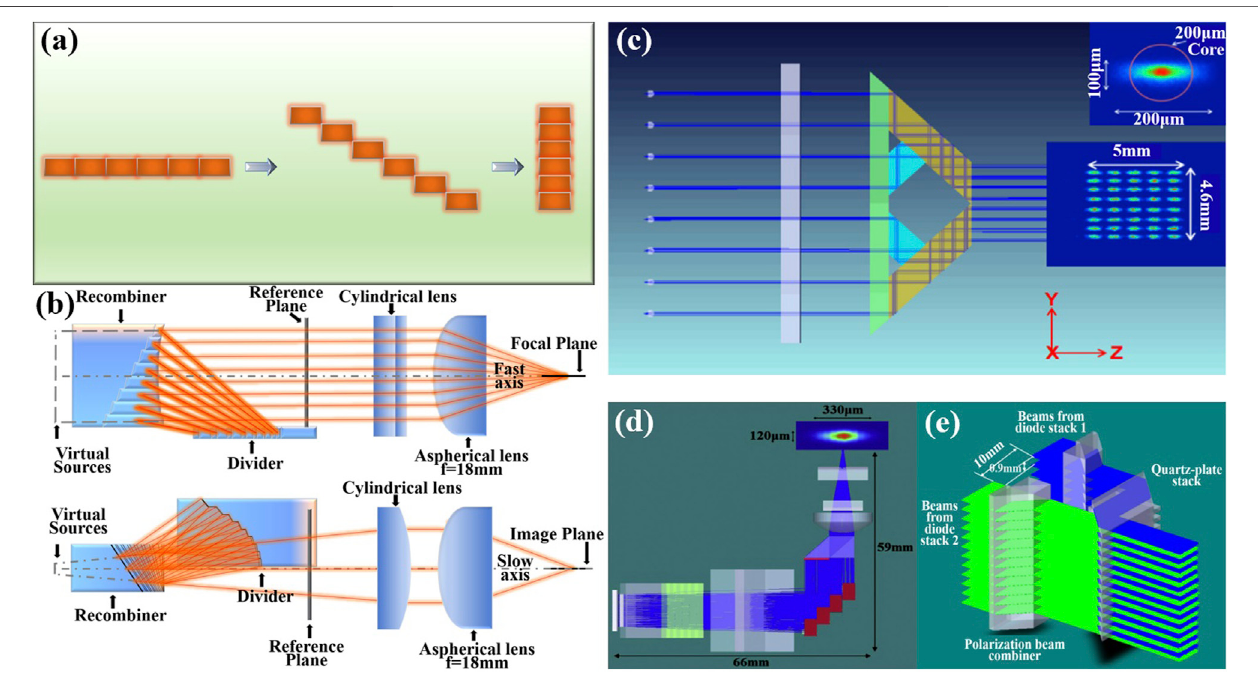
FIGURE 6 | (A) Schematic diagram of beam splitting and reorganization. Adapted from [13]; (B) Side view and top view of the micro-step-mirror division and reorganizationsystem.Adaptedfrom[14]; (C) Schematicdiagramoftrapezoidalprismcompressedbeam.Adaptedfrom[15]; (D) Schematicdiagramof1,000 Wbeam shaping system. Adapted from [16]; (E) Schematic diagram of beam combining of two stacked lasers with 1,400 W power. Adapted from [17].